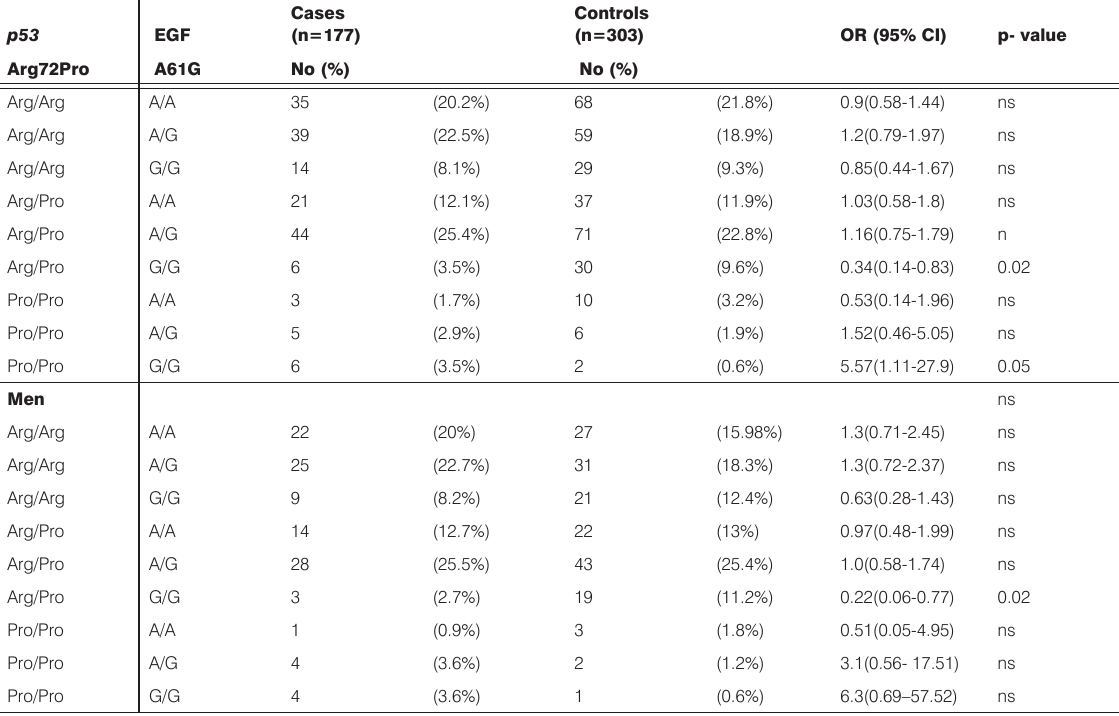
Table 6. Number of all cases and controls, ORs, 95% CIs, χ 2 and P by TP53 Arg72Pro and EGF